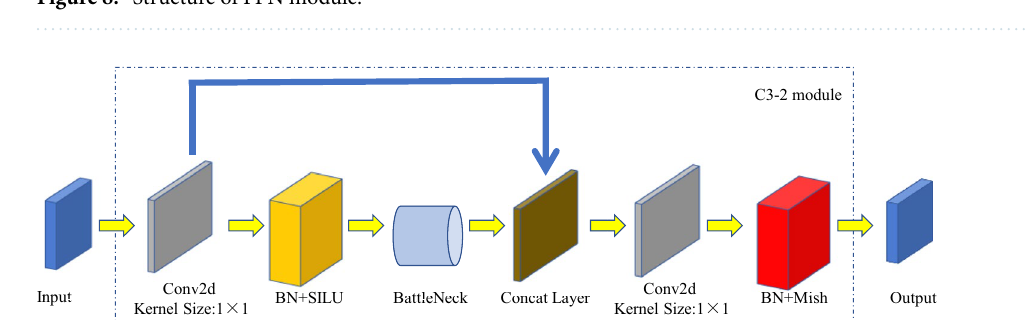
Figure 8. Structure of FPN module.